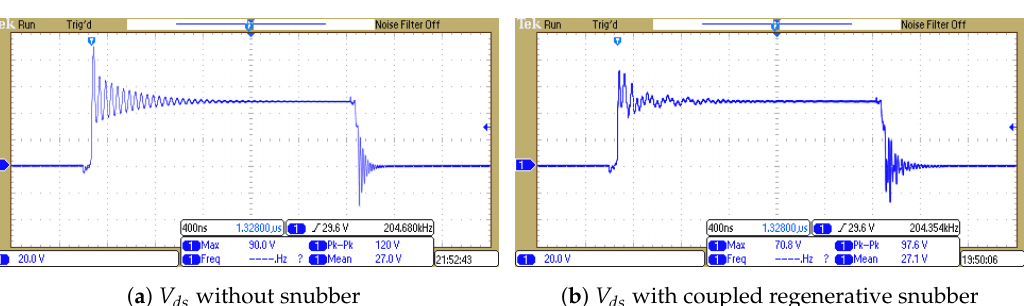
Figure 14. Experimental results for the voltage across the MOSFET switch “ V in = 28 V”.